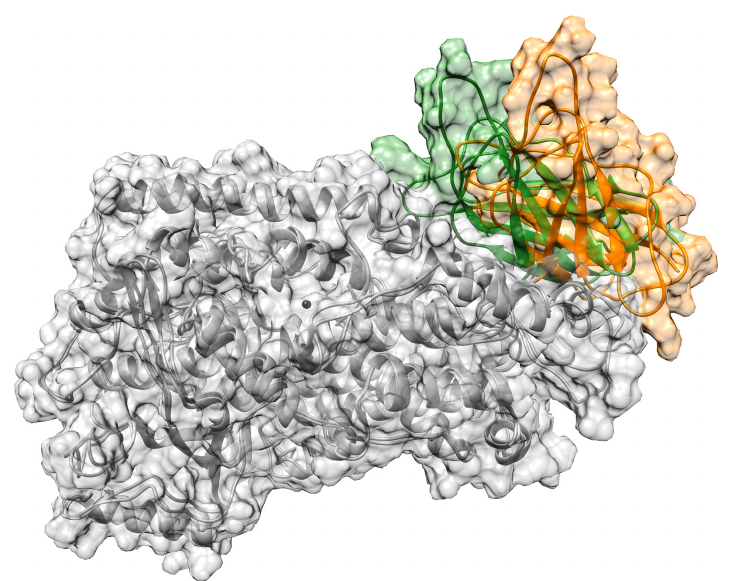
Figure 2. PLAT domain of hALOX12 in the closed (in green) and in the open (in orange) conformation. The C-terminal domain is shown in grey.